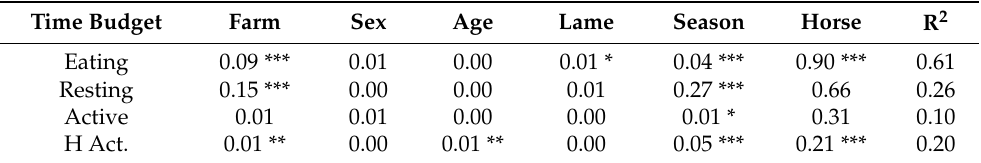
Table 3. ANCOVA results: Sums of squares and significance (* p < 0.05, ** p < 0.01, *** p < 0.001) of the explanatory variables (farm, sex, age, presence/absence of orthopaedic disease (lame), season and horse) and adjusted R 2 for the ANCOVAs for all time budgets.